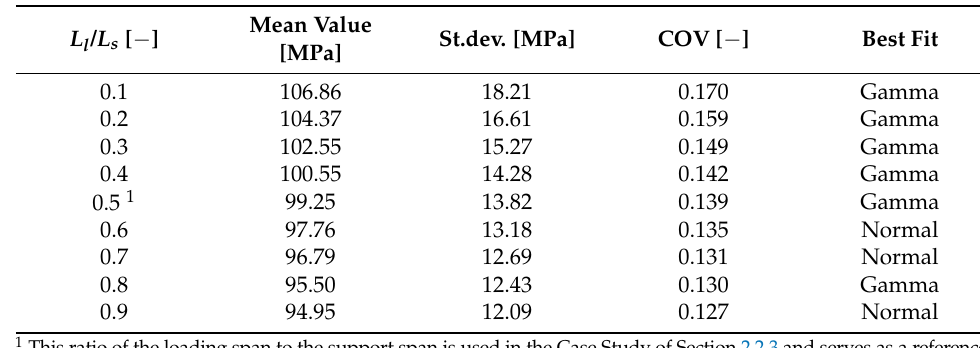
Table 6. Data for a varying ratio of the loading span to the support span.